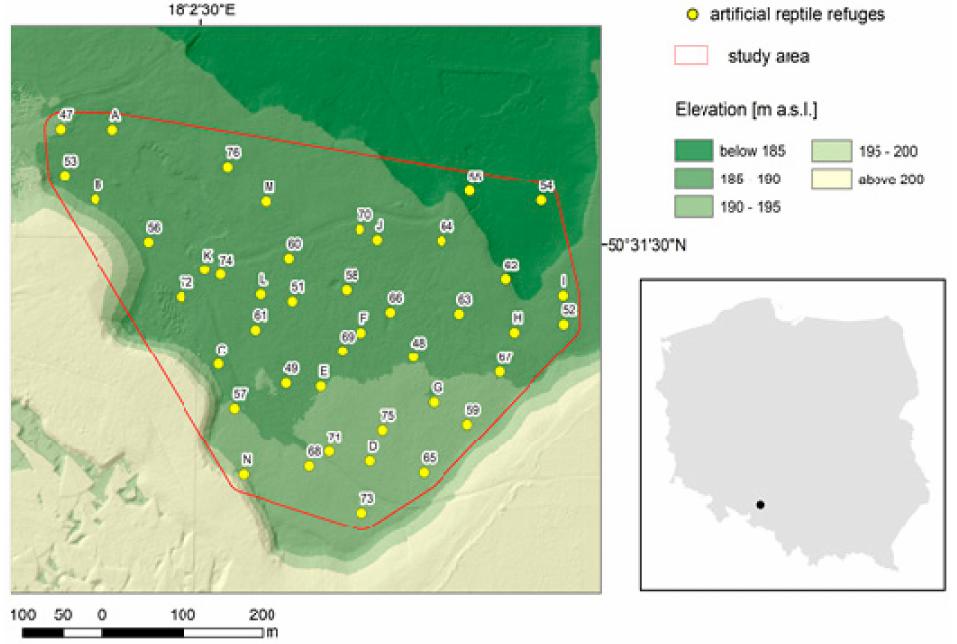
Figure 1. Study area and location of artificial reptile